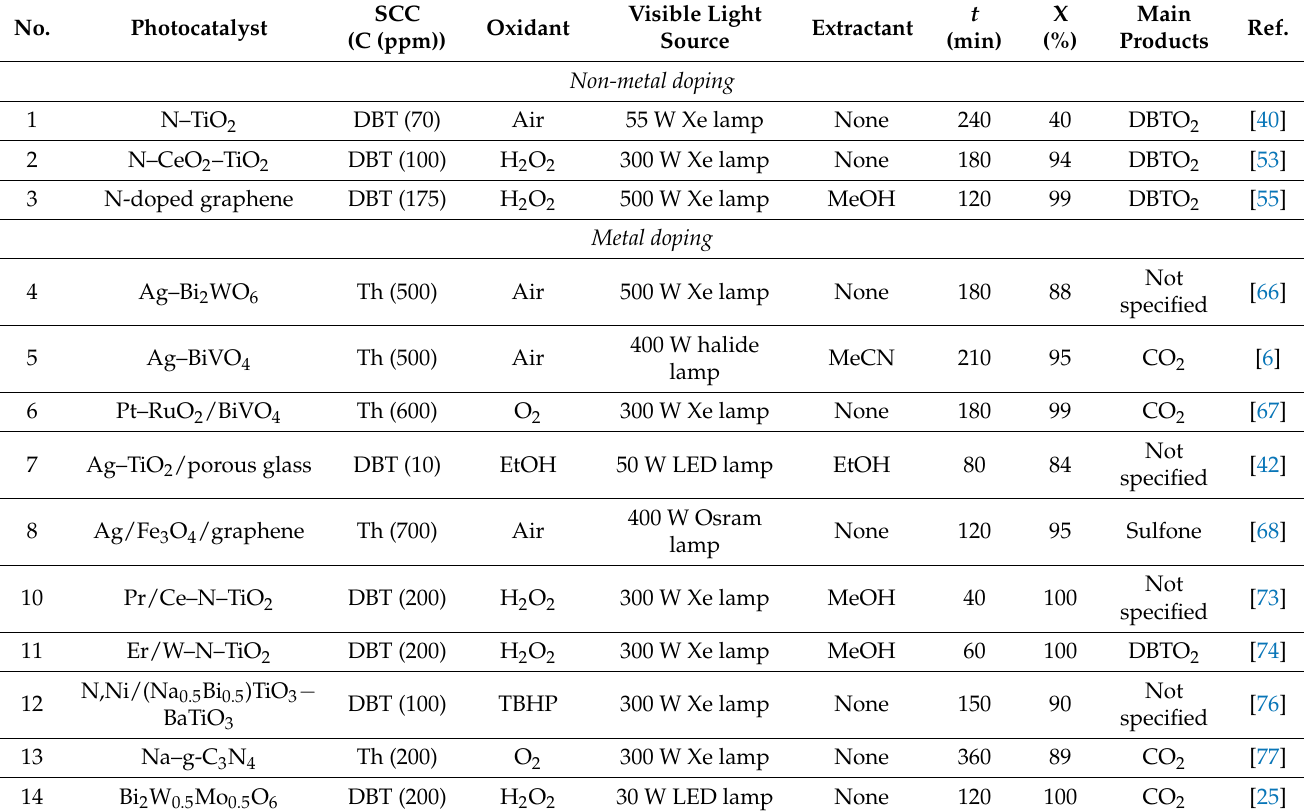
Table 2. Activity of non-metal and metal doped materials in PODS.